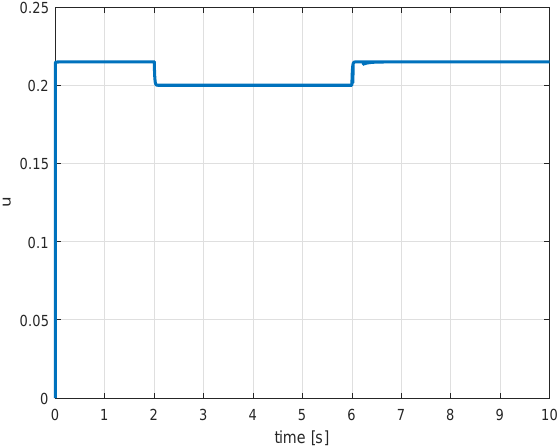
Figure 11. Simulation Case: Equivalent control.